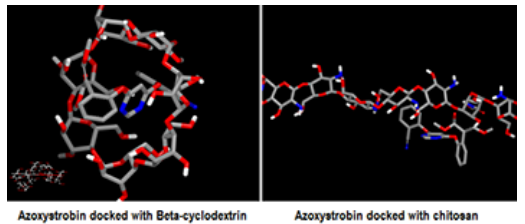
Fig. 2. Molecular modeling study showing the better docking of AZX in βCD cavity than that of chitosan long